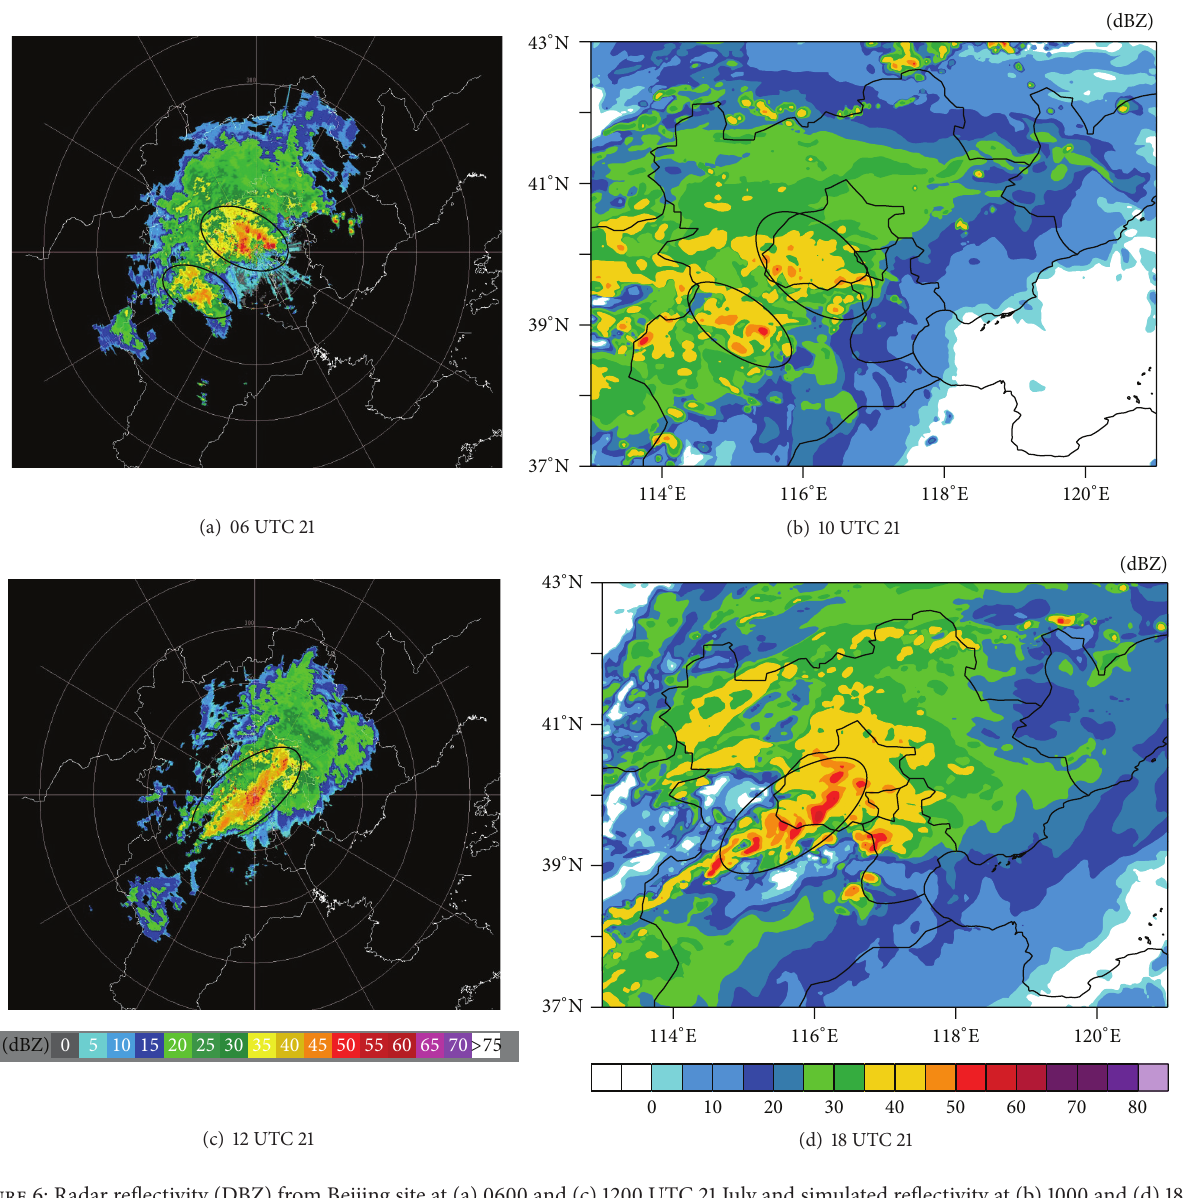
Figure 6: Radar reflectivity (DBZ) from Beijing site at (a) 0600 and (c) 1200 UTC 21 July and simulated reflectivity at (b) 1000 and (d) 1800 UTC 21